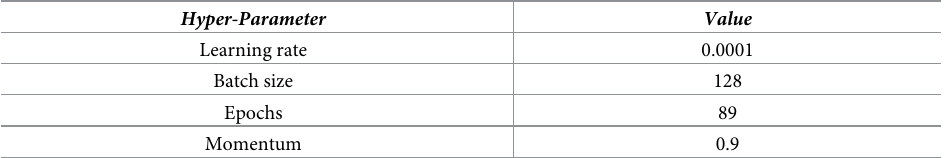
Table 3. Bi-LSTM-A model optimised hyper-parameters.